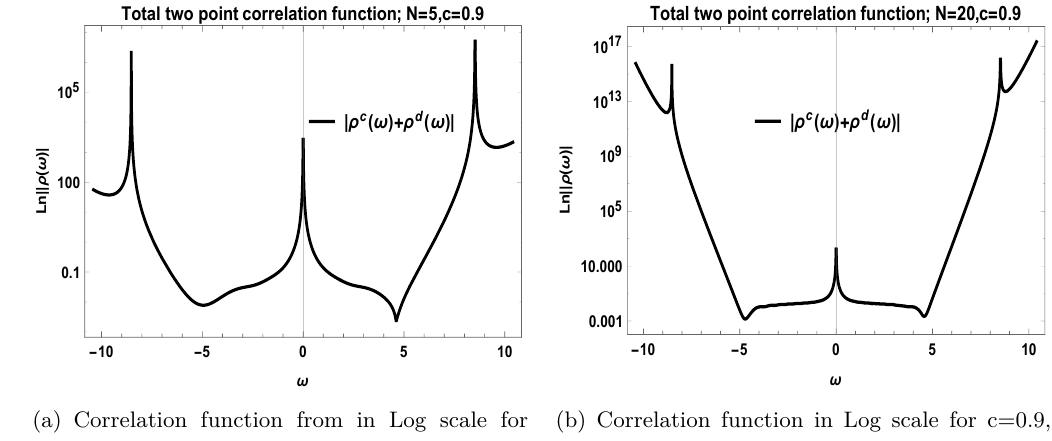
(b) Correlation function in Log scale for c=0.9, N=20.